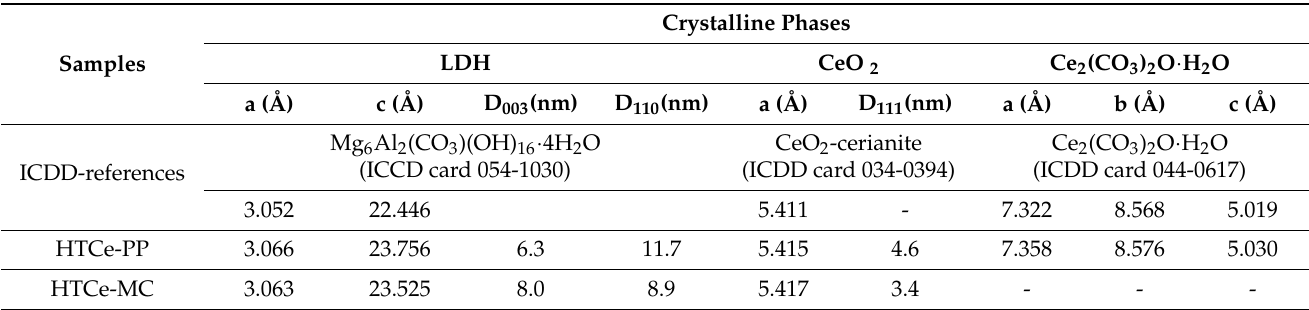
Table 1. The structural data for the dried form of the Ce-containing samples.